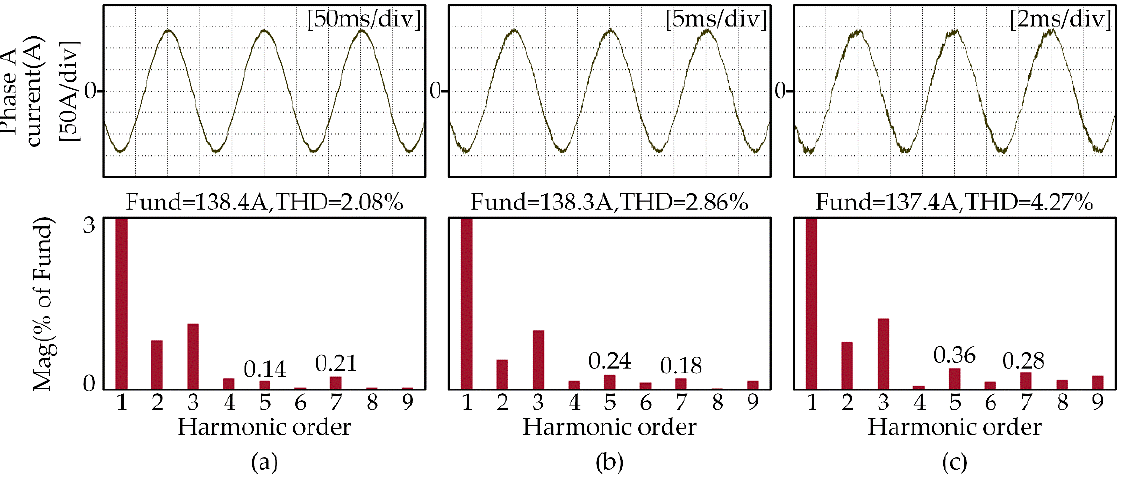
Figure 17. Waveforms of phase A current and its FFT analysis results with proposed current harmonic suppression strategy applied. ( a ) 100 rpm; ( b ) 1000 rpm; and ( c ) 2500 rpm.